Question: Based on the figure, does the quantity rise or fall?
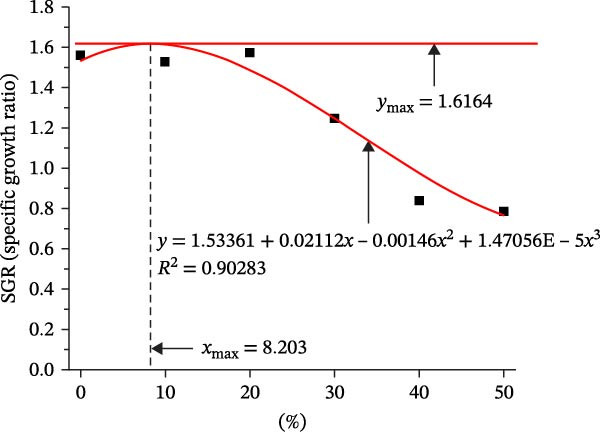
Answer: increasing